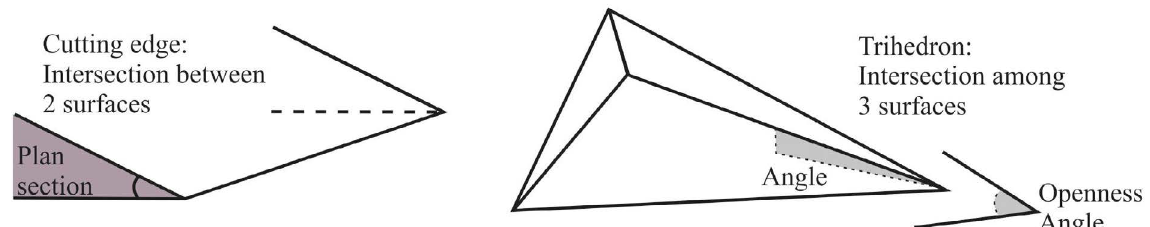
Figure 6. UTFt cutting edge and UTFt